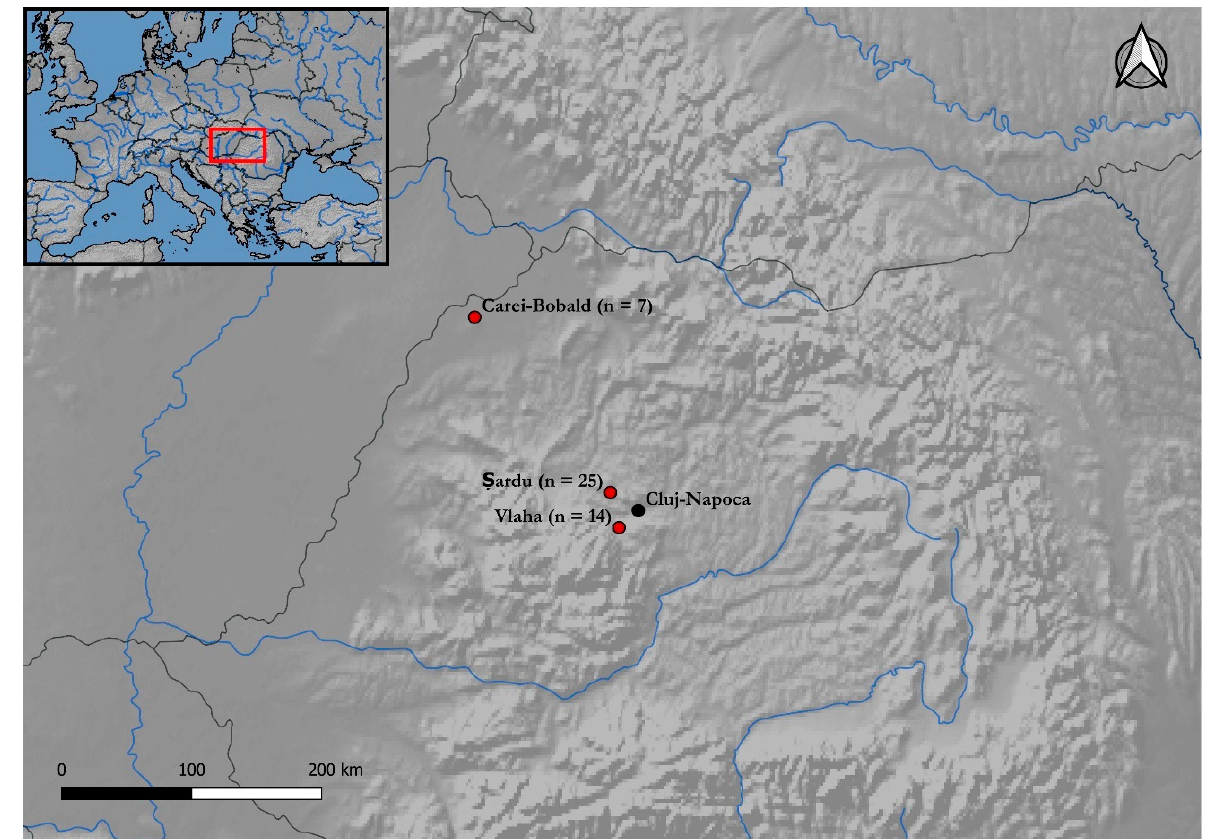
Figure 1. Location of the Gepid cemeteries under study. Sample size is indicated next to cemetery names. The map was generated using QGIS (references: QGIS Development Team QGIS Geographic Information System. Open Source Geospatial Foundation Project 2020.).